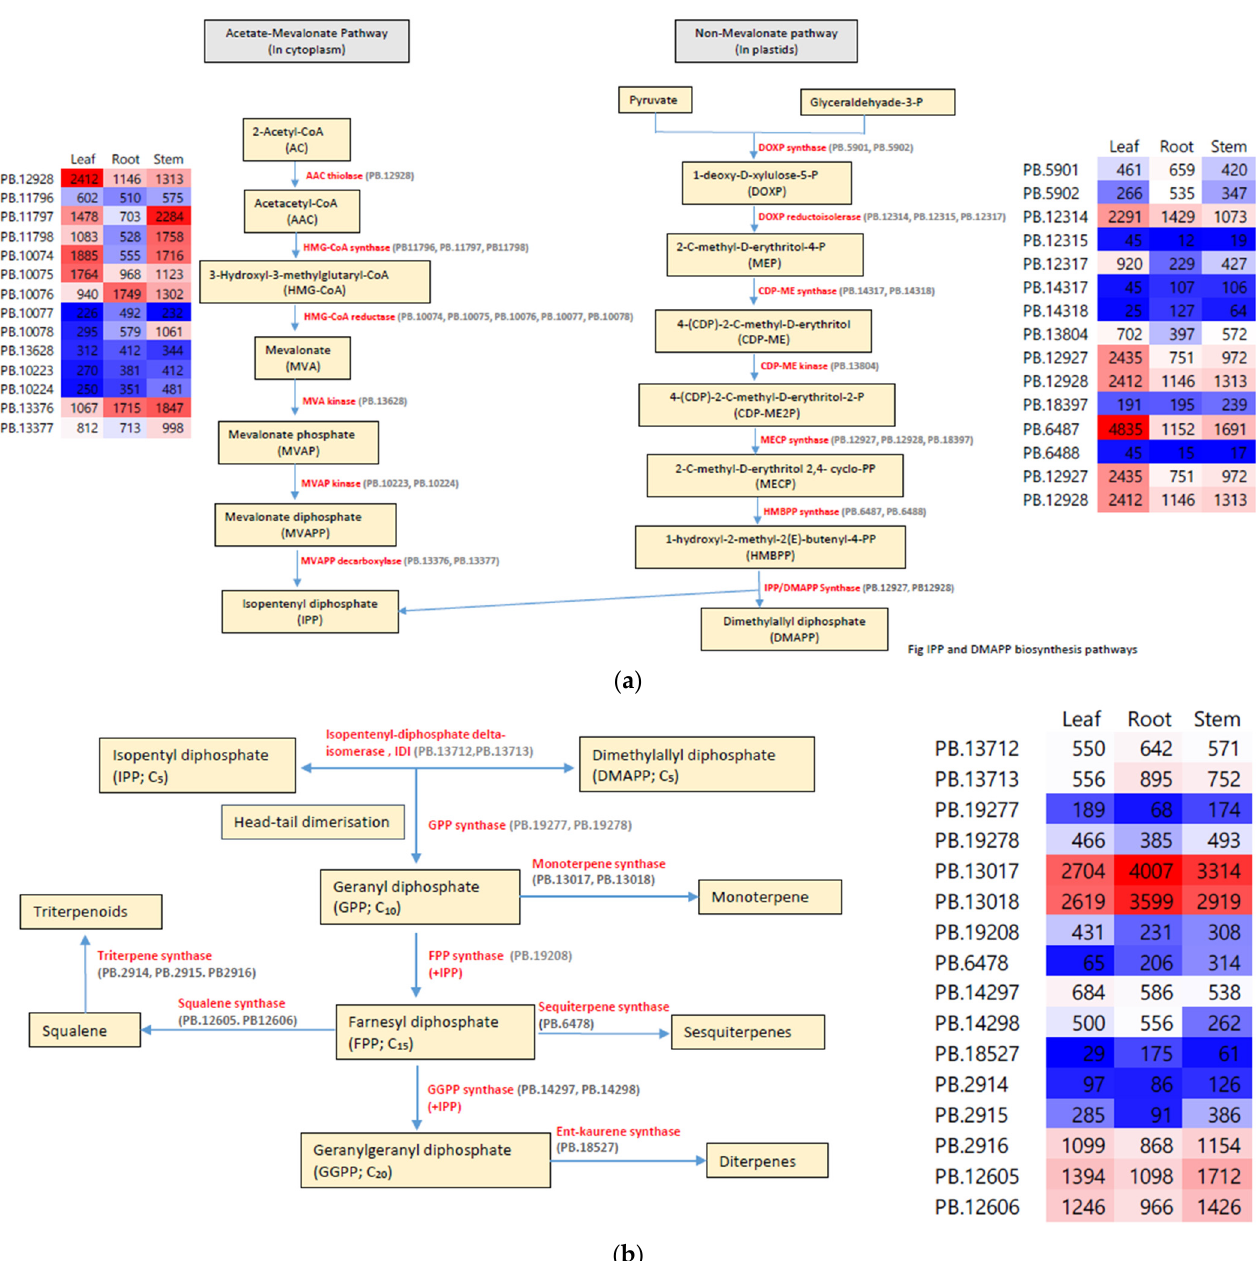
Figure 7. Biochemical pathways of ( a ) the MVA and MEP pathways and ( b ) terpenoid biosynthesis. The numbers in parenthesis are the genes in the E. maculata transcriptomes. The numbers in the heat maps are the FPKM-normalized values.